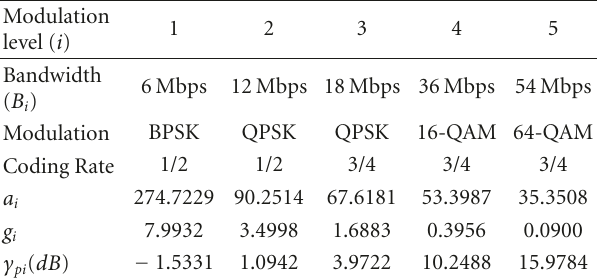
Table 1: The characteristics of modulation for 802.11A. Table 2: Adaptation variables for each factor.